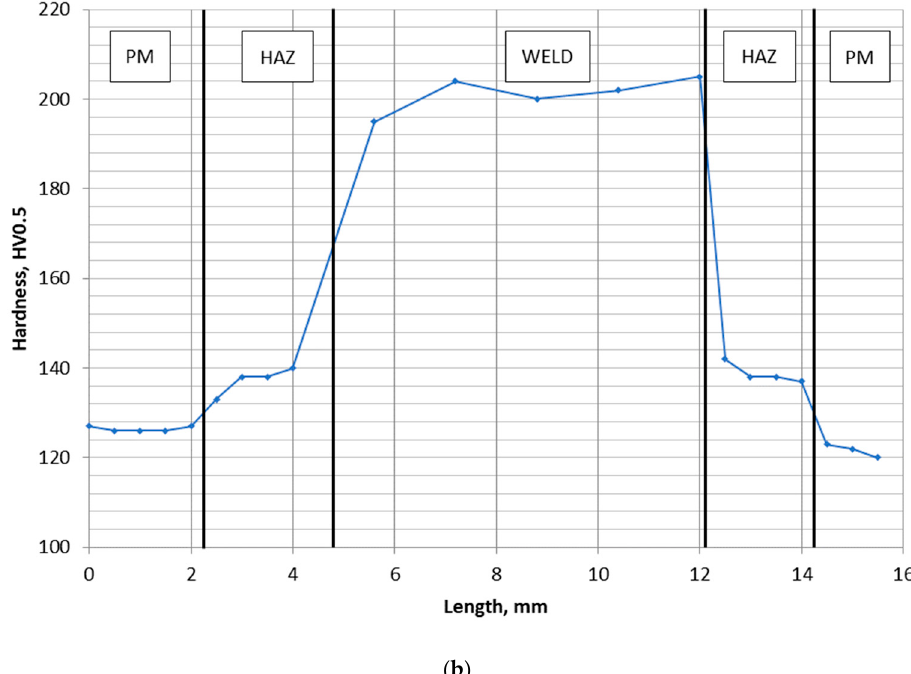
Figure 20. HV5 hardness distribution in the welded joint area; ( a ) measurement line 1, and ( b ) measurement line 2. PM—parent material, HAZ—heat-affected zone.